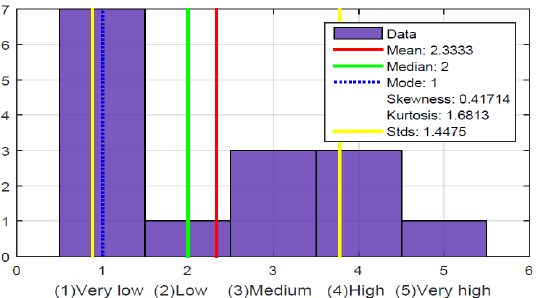
Figure 19. In your opinion, how much do the TV commercials create a distraction that makes you lose track of the play?